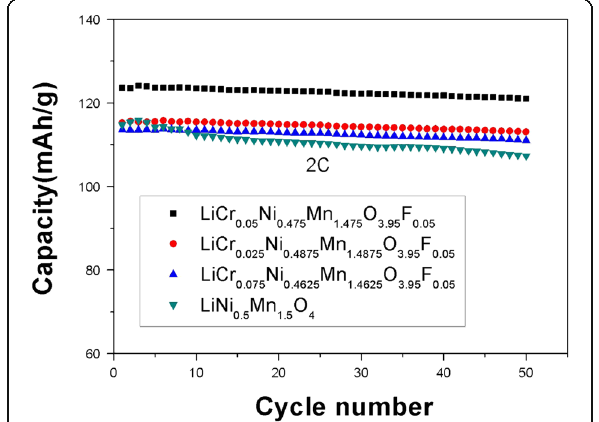
Fig. 7 Cycling performance of LiNi 0.5 Mn 1.5 O 4 and LiCr x Ni 0.5 − 0.5x Mn 1.5 − 0.5x O 3.95 F 0.05 ( x = 0.025, 0.05, 0.075) at 2 C